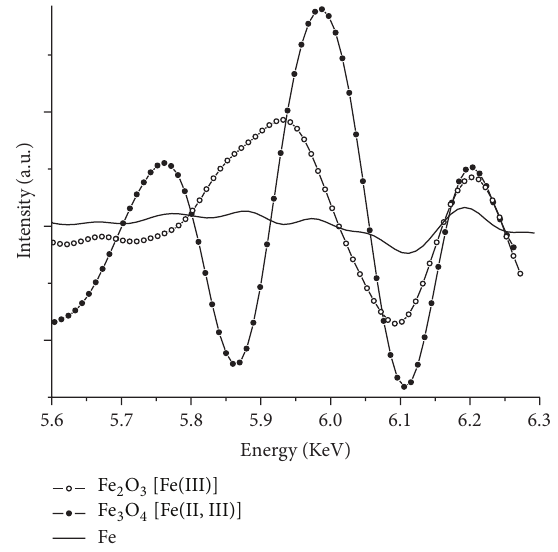
Figure 7: Residuals between experimental Raman spectra and data fitting for pure Fe compounds measured from compacted powder in conventional geometry (45 ∘ -45 ∘ )